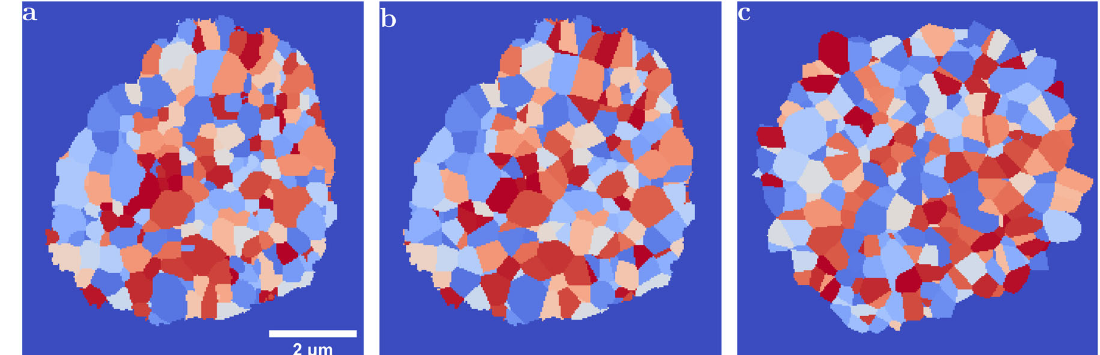
Fig. 4 Visual validation of Laguerre fi t and multi-scale model. 2D slice of segmented FIB-EBSD data ( a ), corresponding slice of the fi tted Laguerre tessellation ( b ), and 2D slice of a sample drawn from the multi-scale model ( c ). All fi gures use the same length